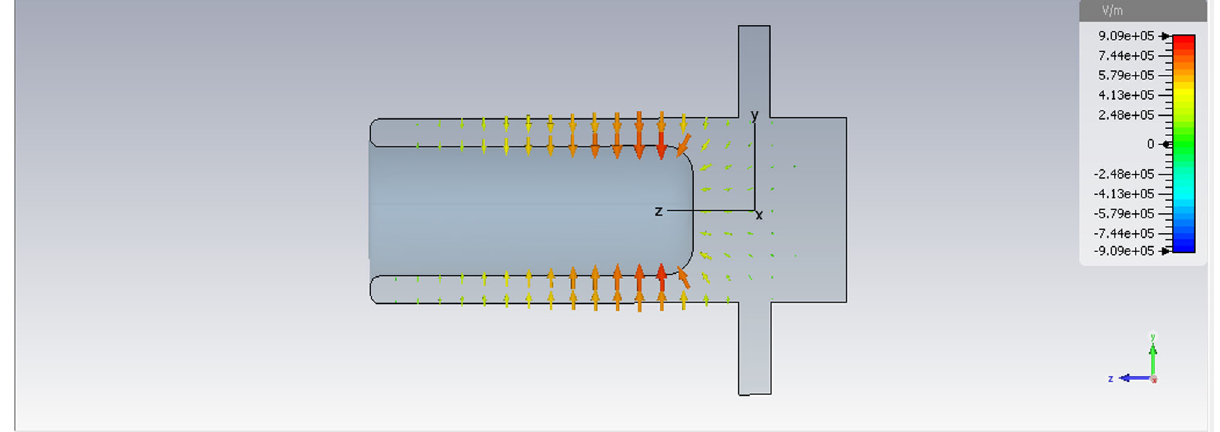
FIG. 45. The cavity electric field profile for the decay ring 40 MHz rf